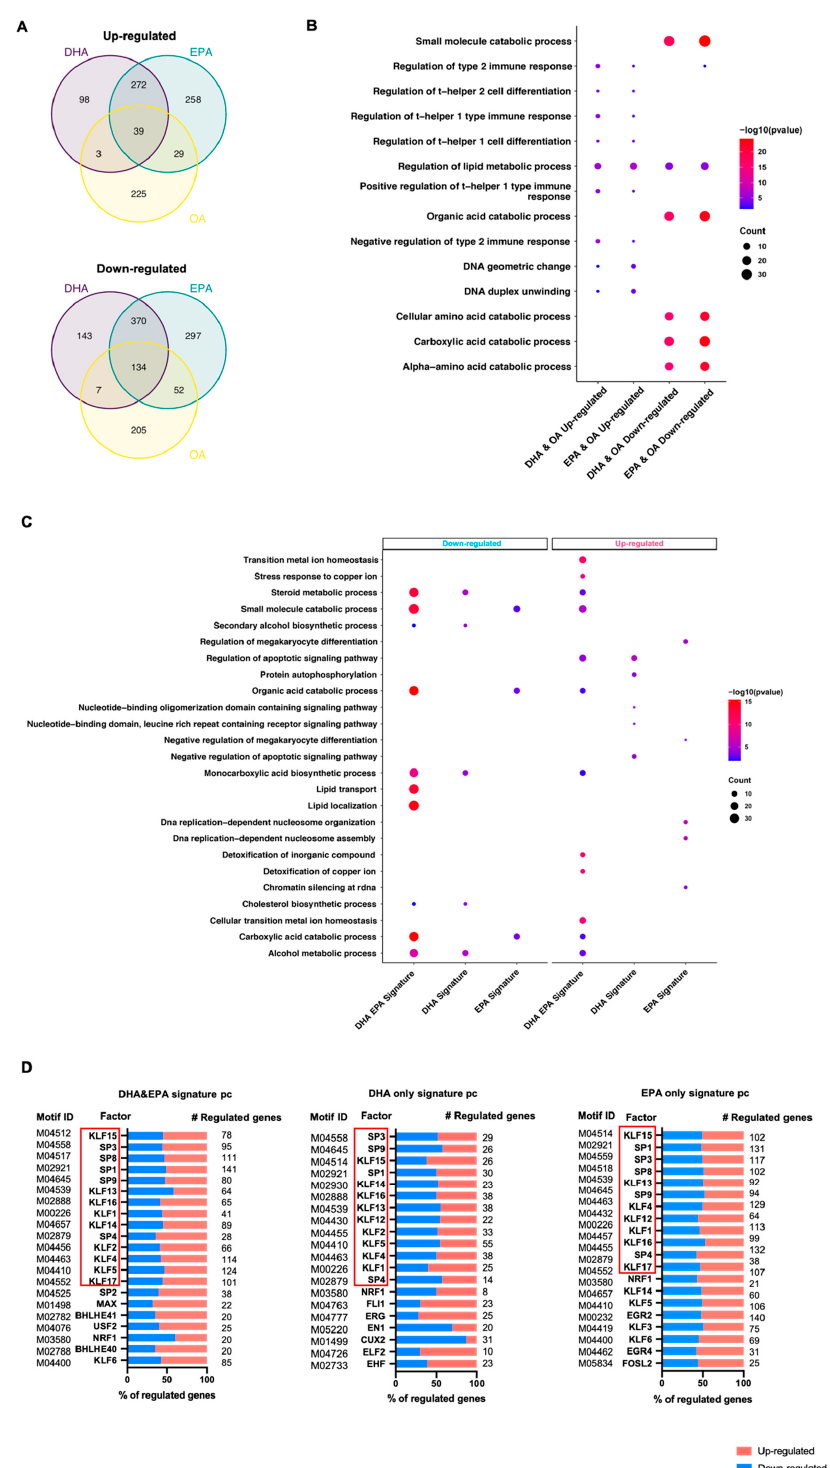
Figure 2. Identification of signature protein coding genes responsive to DHA/EPA supplementation. ( A ) Defining DHA and EPA signature protein coding genes by intersecting DEGs responsive to DHA, EPA, or OA. ( B ) GO Term analyses for DEGs coregulated by DHA and OA or EPA and OA. ( C ) Top 5 enriched GO terms for DHA and EPA commonly regulated, DHA-specific or EPA-specific signature protein coding genes. ( D ) Transcription factor binding motifs enriched in DHA, EPA-specific, or DHA and EPA commonly regulated signature protein coding